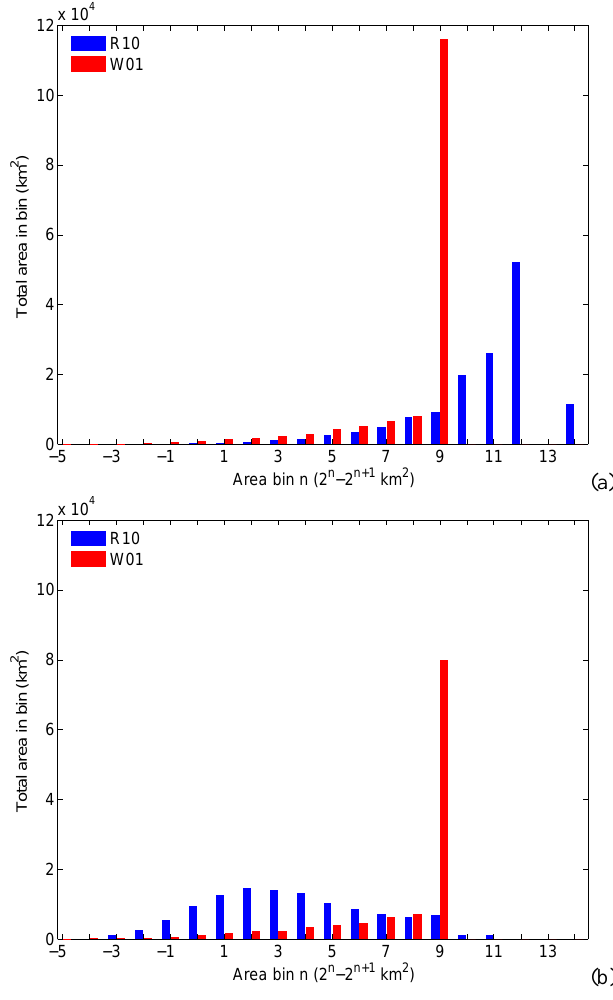
Fig. 7. Initial (1990) GIC area (km 2 ) per size bin for (a) Arctic Canada and (b) Central Asia. R10 uses size bins − 3 (all GIC with area < 2 − 2 km 2 ) to 14 ( > 2 14 km 2 ), W01 uses size bins − 5 ( < 2 − 4 km 2 ) to 9 ( > 2 9 km 2 ).